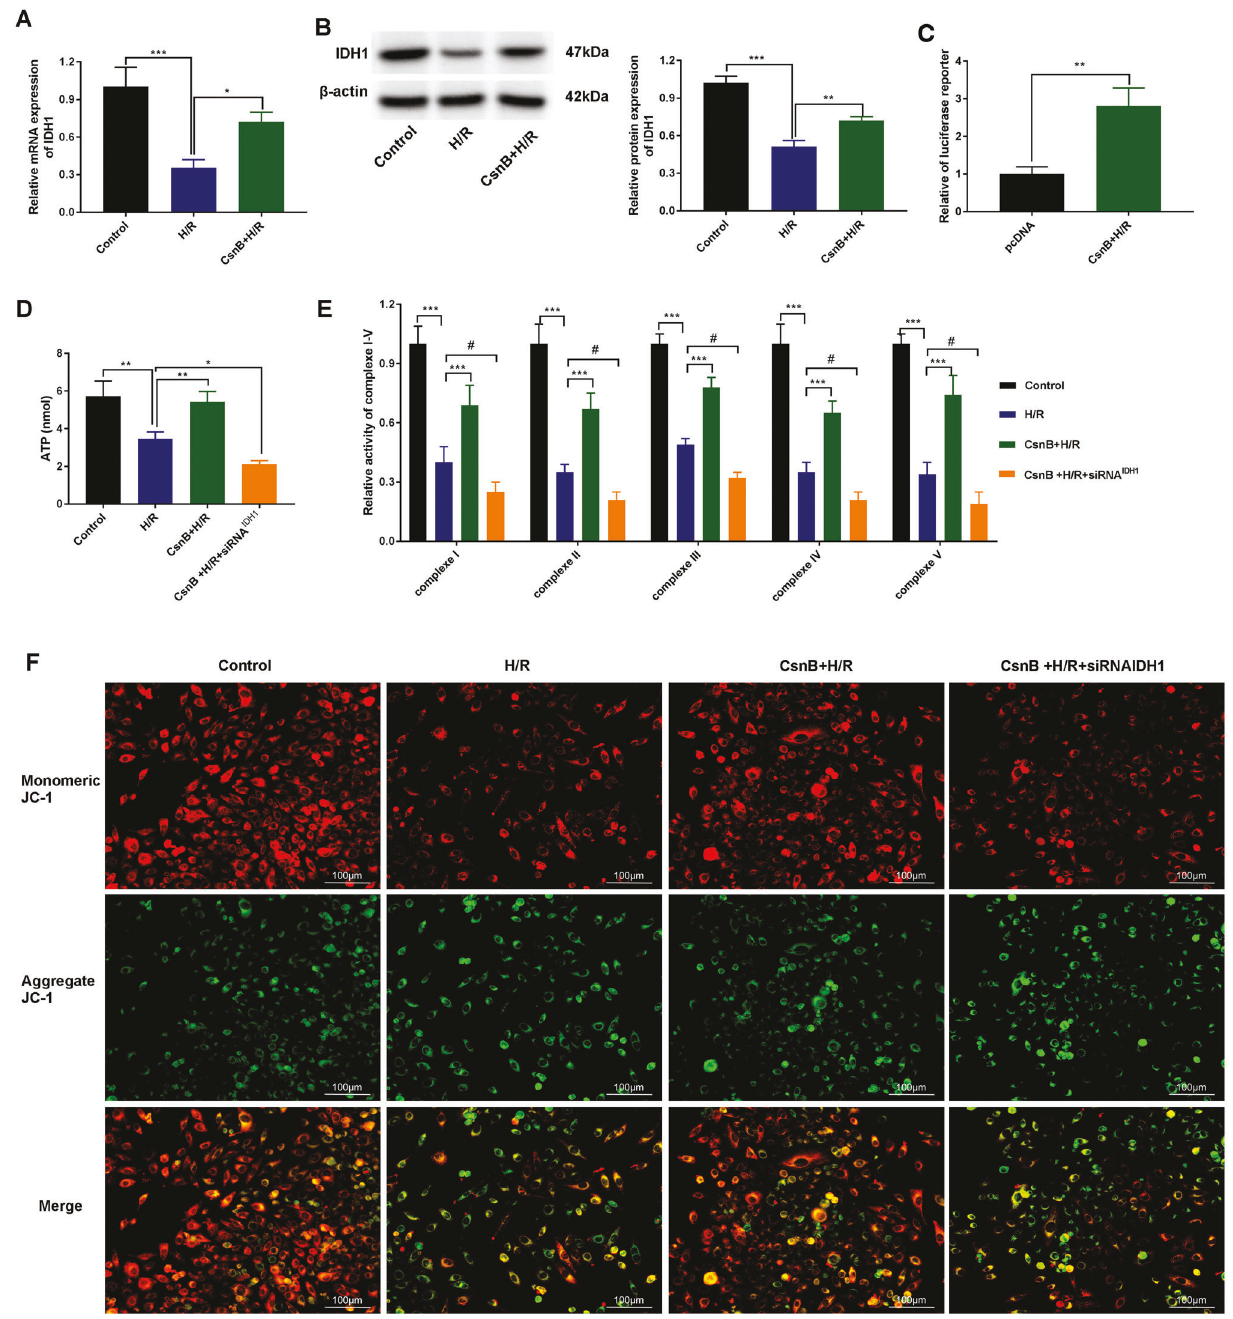
Fig. 5 Nur77 promotes in fl ammation through the regulation of IDH1 in H/R cells. A qRT-PCR and B western blot analysis of IDH1 expression in H/R Raw264.7 cells transfected with CsnB. C Luciferase reporter assays in CsnB transfected H/R Raw264.7 cells. D ATP production in H/R RAW264.3 cells co-transfected with CsnB and siRNA IDH1 . E Complex I, II, III, IV, and V in H/R RAW264.3 cells following co-transfection of CsnB and siRNA IDH1 . F Mitochondrial membrane potential assayed via JC-1 staining in H/R RAW264.3 cells co-transfected with CsnB and siRNA IDH1 (×400, bar = 100 μ m). n = 3. Data represent the mean ± SD. * P < 0.05, ** P < 0.01, *** P < 0.001, # P < 0.05. Metabolic parameters antibodies: anti-HDAC1, anti-Nur77, and anti-IDH1 (1:1000) for 24 h at 4 °C. Cells were treated with Seahorse XF assay medium (pH = 7.4) Membranes were labeled with horseradish peroxidase (HRP)-conjugated supplemented with 2 mM glutamine, 1 mM pyruvate, and 10 mM anti-mouse antibodies for 1 h. Luminal agent was used for protein glucose. Cells were incubated in CO 2 free conditions for 1 h hour at detection (SC-2048, Santa Cruz Biotechnology, CA, USA). 37 °C. Oxygen consumption (OCR) and extracellular acidi fi cation (ECAR) rates were measured following the addition of glucose, 2-deoxy- D - ELISA glucose (2DG) and oligomycin. Cells were further assessed following Blood samples were collected and serum IL-6, TNF-a, IL-10, and IL-1 β levels treatment with carbonyl cyanide 4-tri fl uoromethoxyphenylhydrazone were evaluated by ELISA (USCN Life Science, Inc., China). Absorbances were (FCCP), oligomycin, glucose, 2-DG, rotenone, and antimycin A (Rot/AA). read on a microplate reader (Bio-Tek Instruments, Inc., USA). Adenosine triphosphate (ATP) levels and metabolic parameters Cell Death Discovery (2023)